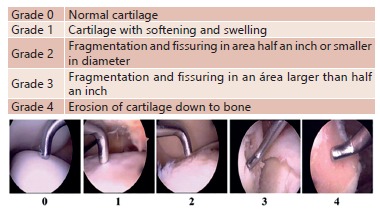
Outerbridge classification
9